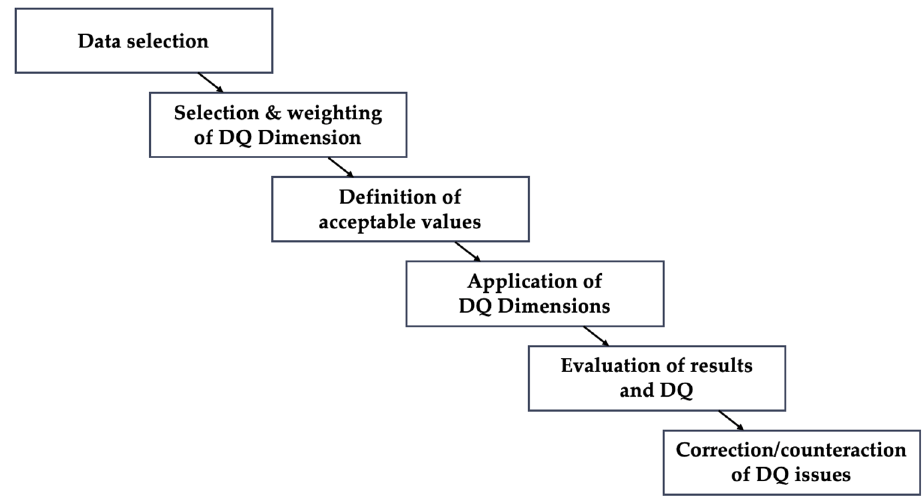
Figure 3. Data Quality (DQ) assessment steps suggested by DAMA UK [46], own illustration.